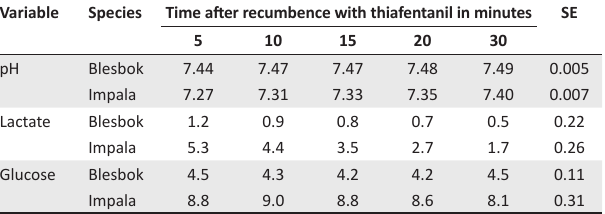
TABLE 1b: Species comparison of arterial blood pH, lactate in mmol/L and glucose in mmol/L over time and standard error during immobilisation,